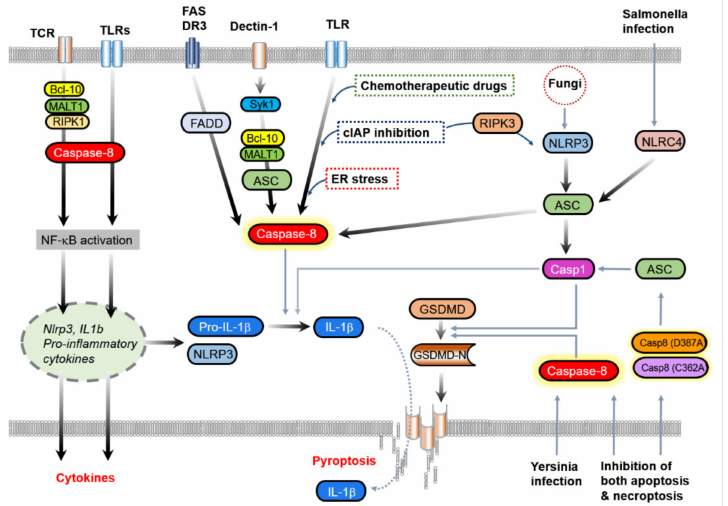
Figure 3. Caspase-8 promotes inflammation through IL-1 β and GSDMD processing, activation of the inflammasome, and NF- κ B activation. Caspase-8 can directly cleave IL-1 β upon stimulation of FAS/Dr3, Dectin-1, and TLR with cellular stress conditions, such as chemotherapeutic drugs, ER stress, and cIAP inhibition. Caspase-8 mediates pyroptosis by direct processing of GSDMD in response to Yersinia infection or by induction of inflammasome activation through caspase-1 activation by its scaffolding function. Fas cell surface death receptor (FAS) and death receptor 3 (DR3) signal FADD-caspase-8 to process IL-1 β and dectin-1 ligation induces IL-1 β processing through caspase-8 assisted by Bcl-10, MALT-1, and ASC. Caspase-8 contributes to T-cell receptor (TCR)- or TLR-induced NF- κ B activation, production of proinflammatory cytokines, and priming of the